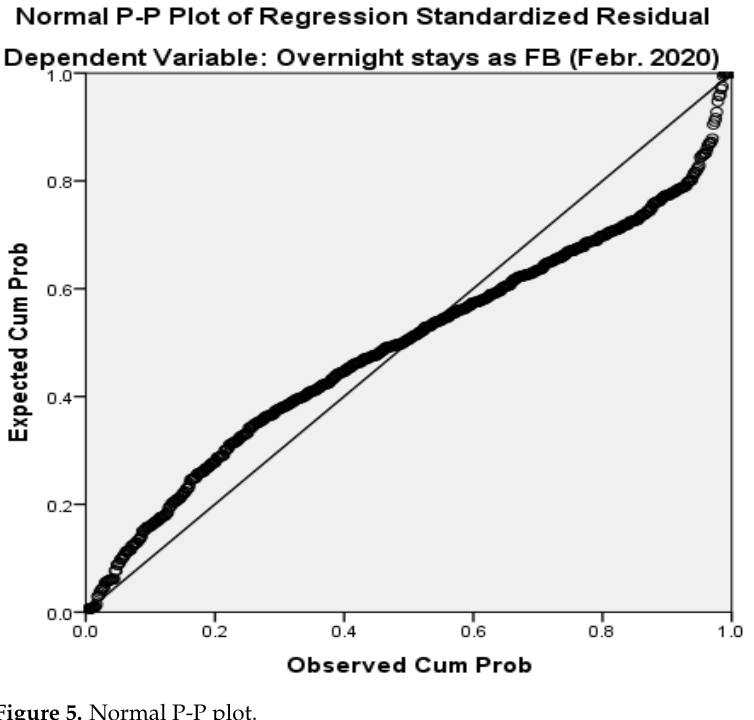
Figure 5. Normal P-P plot.